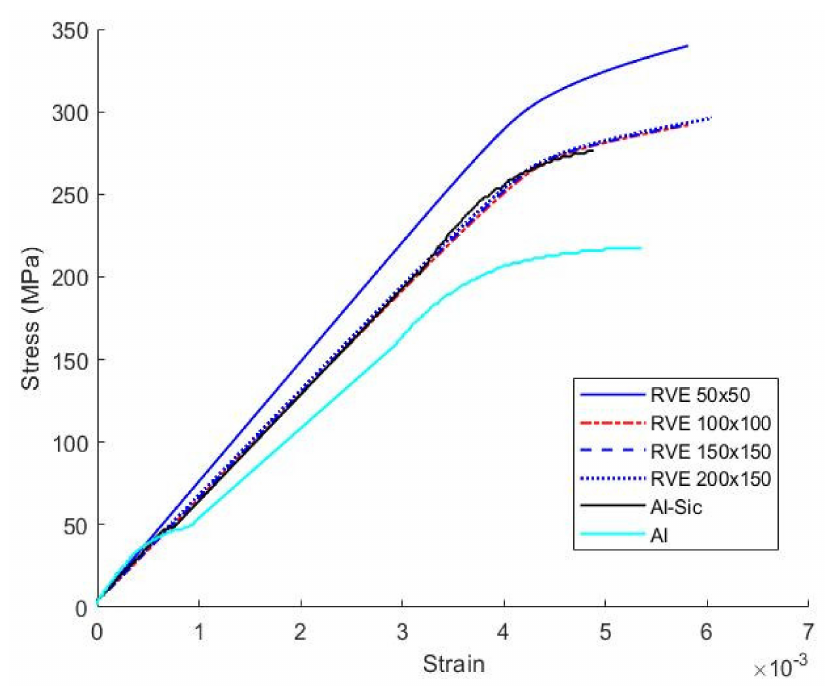
Figure 11. The experimentally obtained stress–strain curve vs. the numerically obtained curves for all RVE sizes. In the legend Al, & Al-Sic. Refer to experimental results.